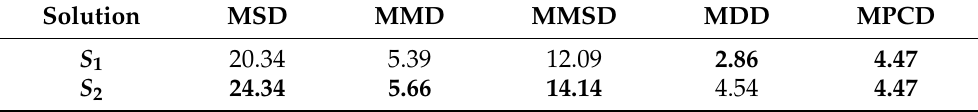
Table 1. Evaluation of the five diversity metrics over the solutions S 1 and S 2 depicted in Figure